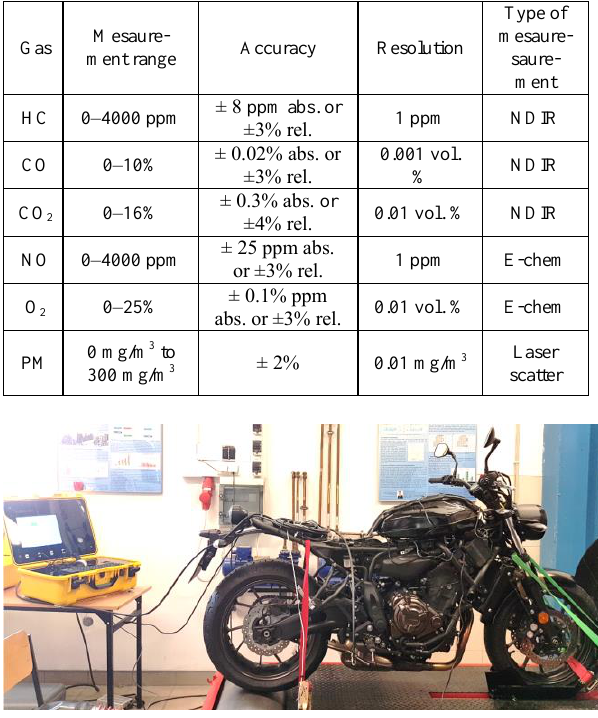
Fig. 5. Picture of the tested motorcycle along with the measuring apparatus on the designated dynamometer